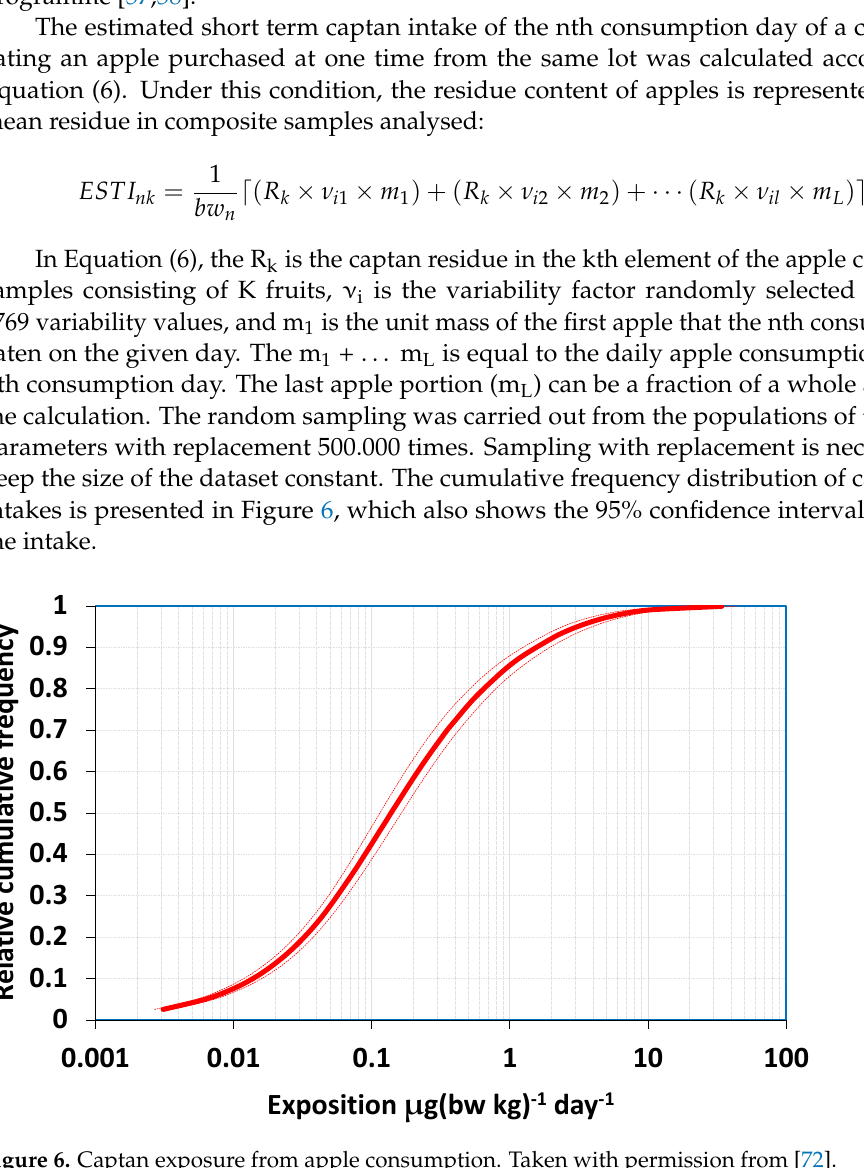
Figure 6. Captan exposure from apple consumption. Taken with permission from [72].